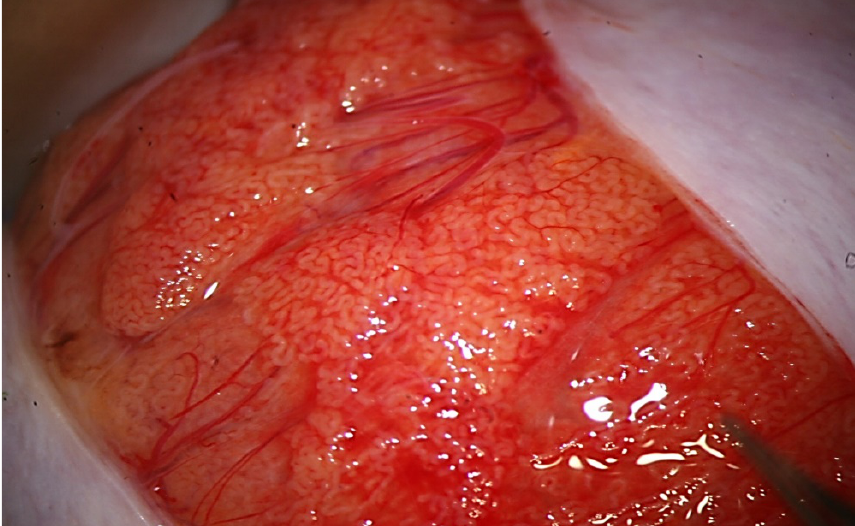
Figure 2. Testicular parenchyma at medium-high magnification.